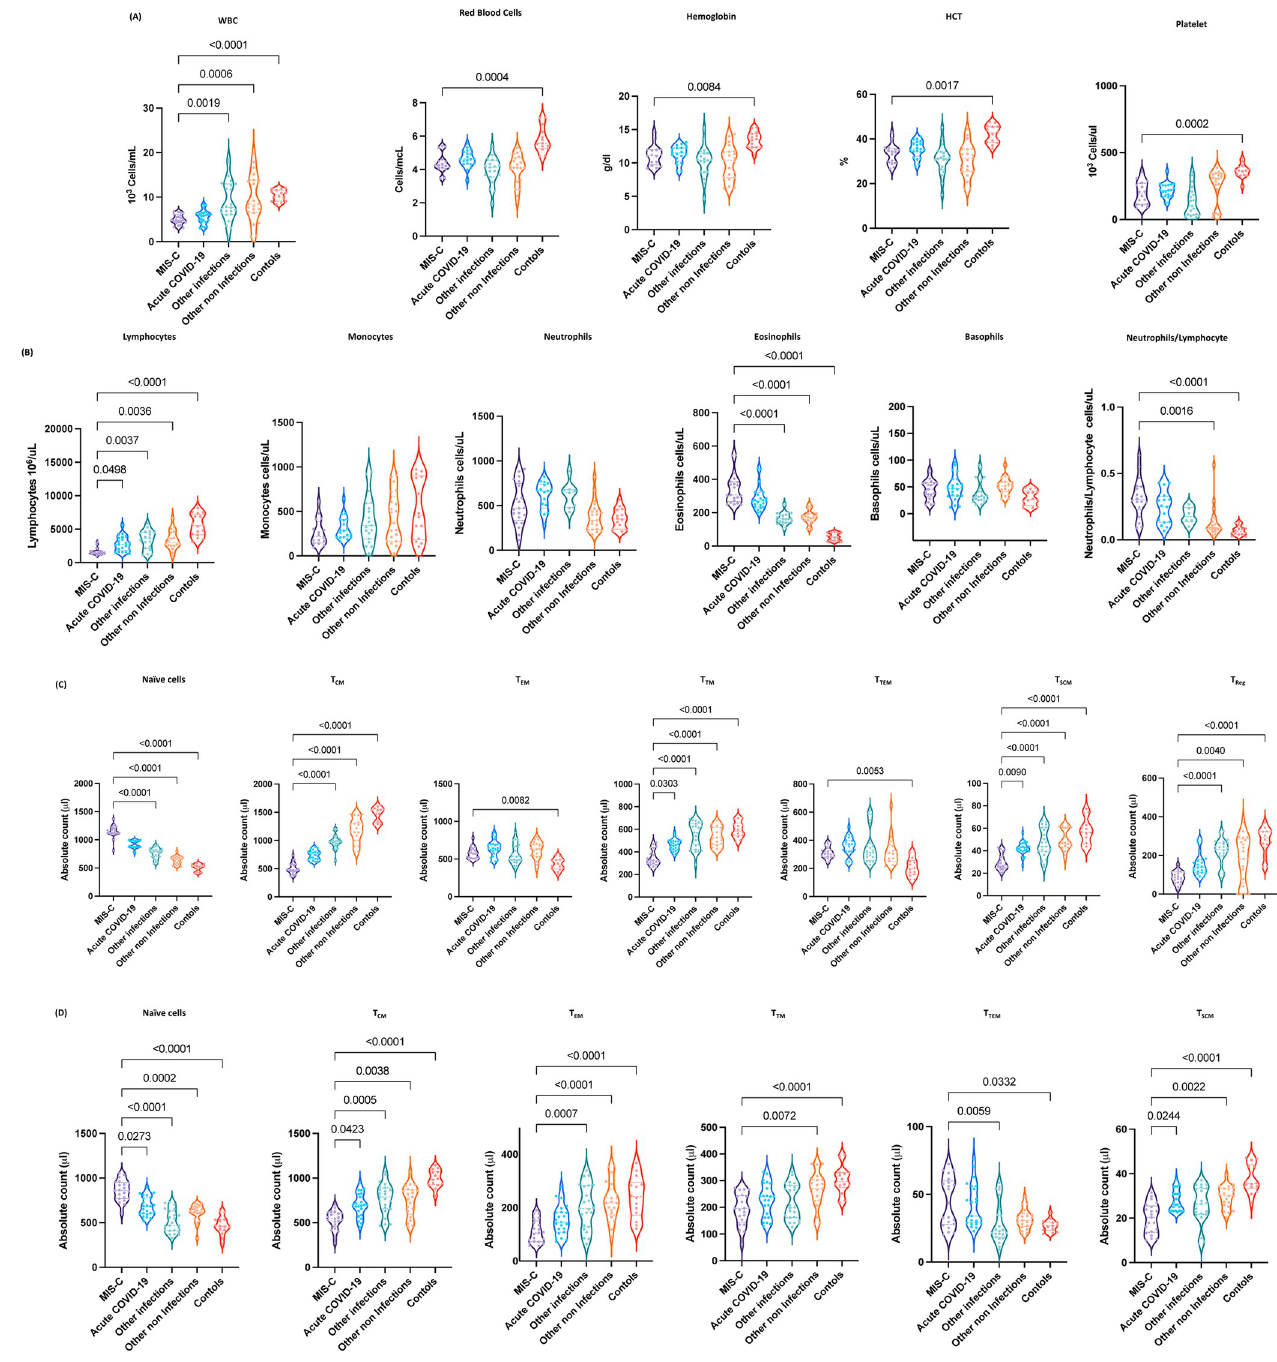
Fig 1. CD4 + and CD8 + T cell subsets are altered in MIS-C. (A) Analysis of WBC, RBC, Hb, HCT and platelets (B) Analysis of absolute count of WBC, lymphocytes, monocytes, neutrophils, eosinophils, basophils and neutrophils/lymphocyte ratio were shown for children with MIS-C (n = 21), acute COVID-19 (n = 23), other infectious (n = 23), other non-infectious diseases (n = 21) and controls (n = 14). (C) Absolute numbers of CD4 + T cell subsets in MIS-C (n = 21), acute COVID-19 (n = 23), other infectious (n = 23), other non-infectious diseases (n = 21) and controls (n = 14). The data are represented as scatter violin plots with each circle representing a single individual. p values were calculated using the Kruskal-Wallis test with Dunn’s post-hoc for multiple comparisons. (D) Absolute numbers of CD8 + T cell subsets in MIS-C (n = 21), acute COVID-19 (n = 23), other infectious (n = 23), other non-infectious diseases (n = 21) and controls (n = 14). The data are represented as scatter violin plots with each circle representing a single individual. p values were calculated using the Kruskal-Wallis test with Dunn’s post-hoc for multiple comparisons.